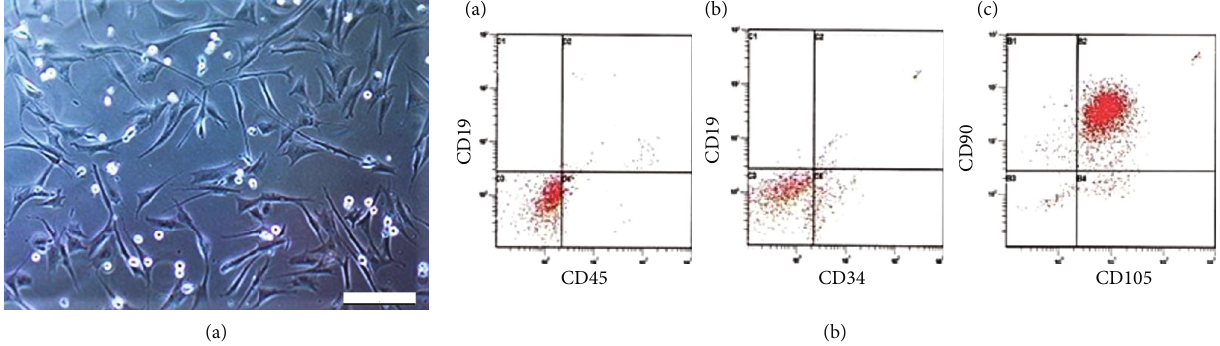
Figure 1: (a) Representative photographs of adipose mesenchymal adipose stem cells from 2 nd passage showed spindle-shaped fi broblastic cell morphology. Bar length = 200 μ m . (b) Representative dot plots of ASCs stained with the cell surface markers. ASCs have negative results for CD19, CD34, and CD45 ((b) A, B) and positive results for CD90 and CD105 ((b), C).